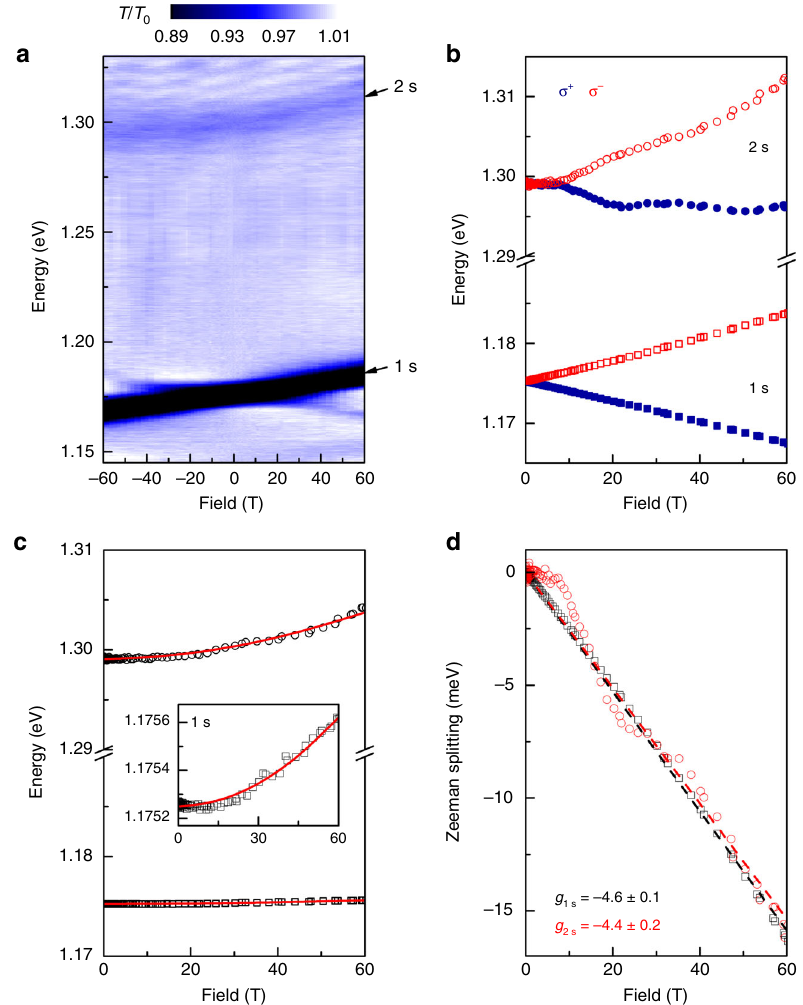
Fig. 5 Magneto-optical spectroscopy of monolayer MoTe 2 . a Normalized intensity map of the fi eld-dependent transmission spectra through monolayer MoTe 2 , showing the A:1 s ground state exciton and the A:2 s excited state. Due to a small (<5 %) polarization leakage, a weak trace of the oppositely polarized 1 s state is also visible. b Energies of the excitons in σ ± polarization. c Averaged exciton energies showing diamagnetic shifts. Red lines show ¼ 0 : 36 m r ¼ 6 : 4 nm, κ ¼ 4 : 4, and E ¼ 1 : 352 eV. Inset: Expanded plot of the 1 s exciton energy, calculated energies (see text). Parameters: m 0 , 0 r gap showing its very small quadratic diamagnetic shift. d The valley Zeeman splitting of the 1 s and 2 s excitons; dashed lines show linear fi